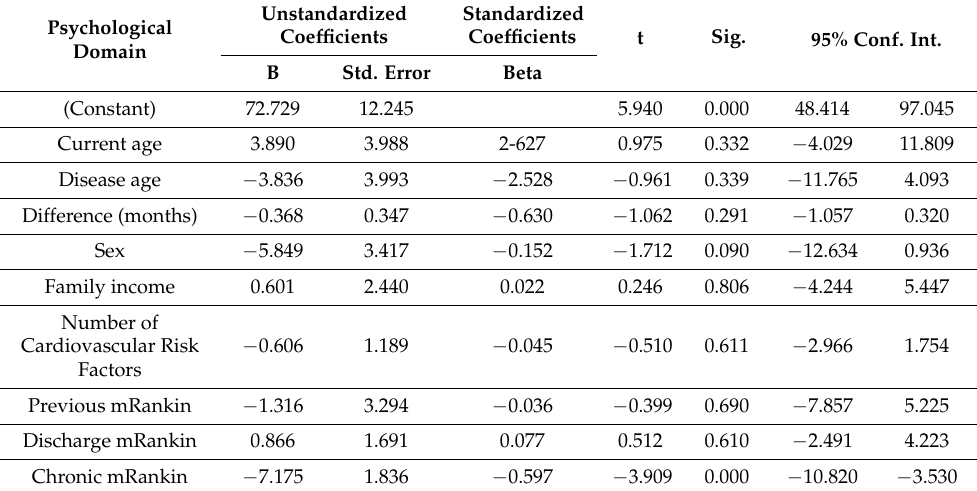
Table 6. Multivariate analysis for Psychological domain.